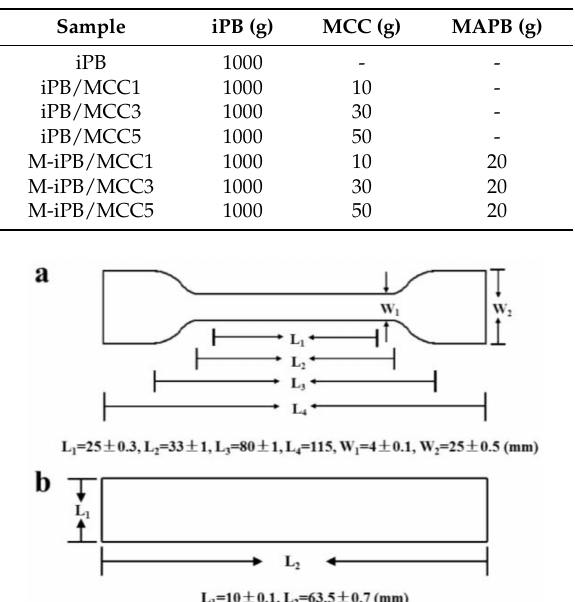
Table 1. Formulae of the Isotactic Polybutene-1(iPB)/Microcrystalline cellulose (MCC) composites.